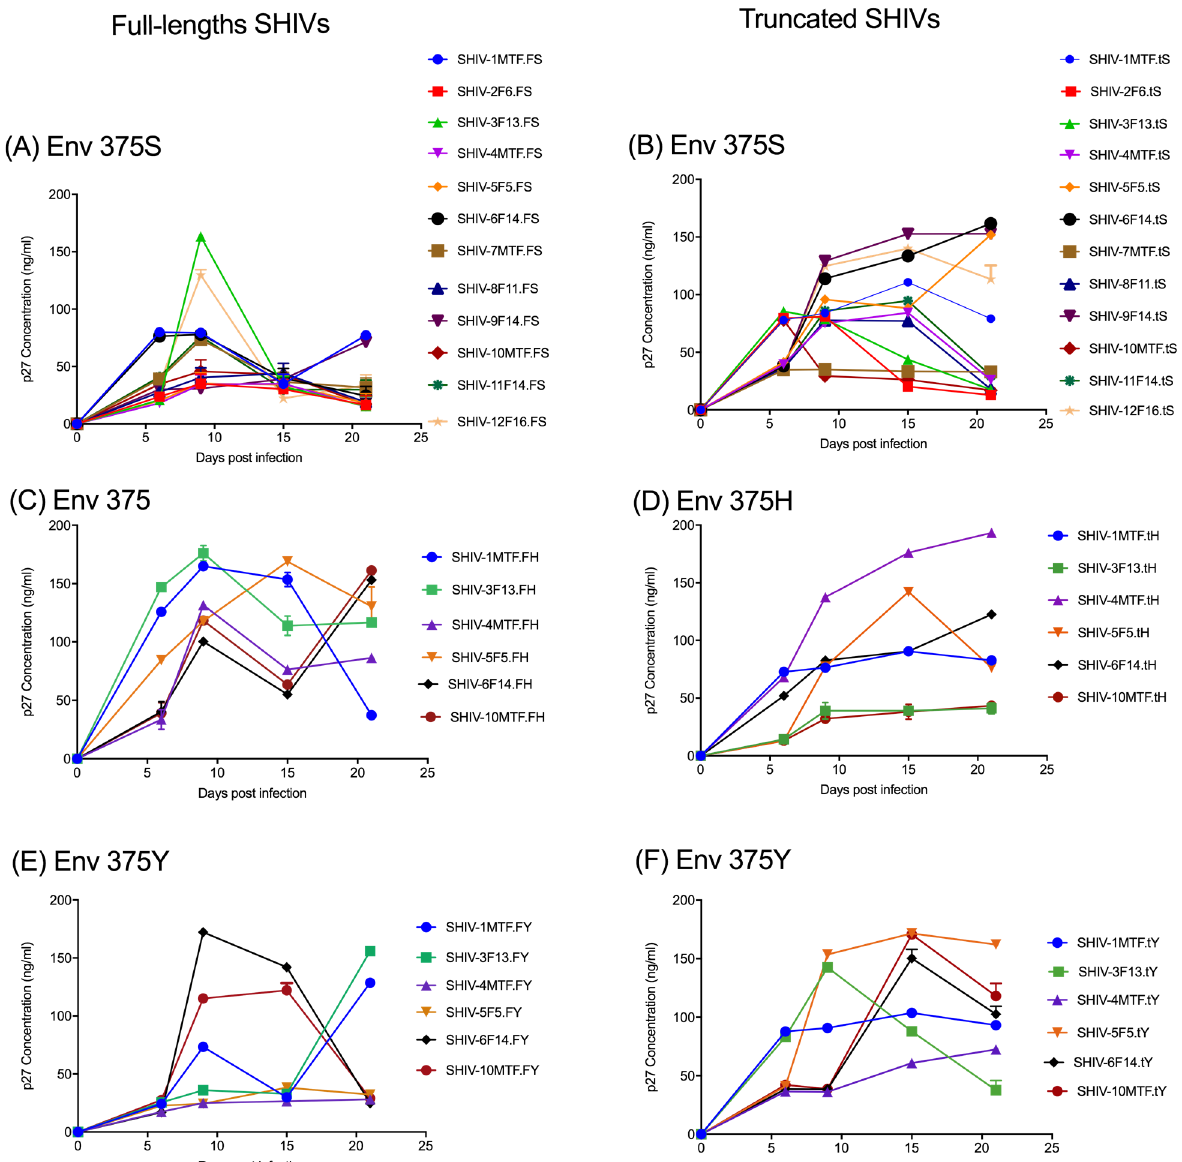
Fig 4. Replication kinetics of newly generated SHIVs in rhesus macaque PBMCs. Pooled PBMC from randomly selected naive RM donors were stimulated with concanavalin A (Con-A) for 48-72hrs washed and infected with 200TCID 50 of various SHIVs as described in the method. Culture supernatents were harvested every three days upto 20-25 days and SIV gag protein (P27) were measured using P27 ELISA kits. Left panel represents a replication kinetics of full-length SHIVs as well as S375H/Y mutation and right panel represents truncated SHIVs and S375H/Y mutation.